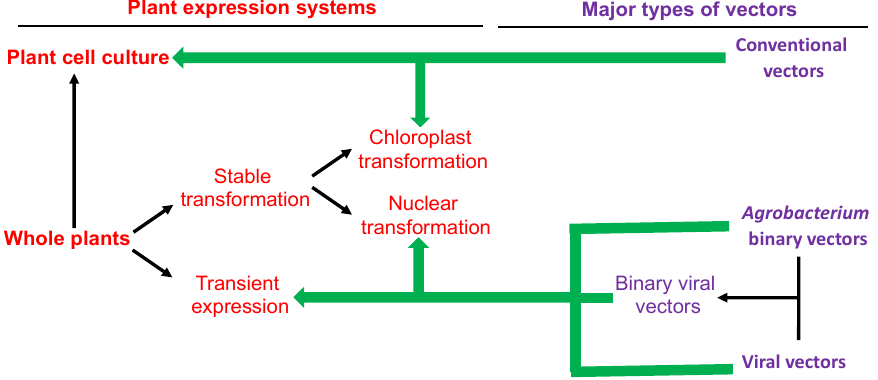
Figure 1. Major plant expression systems and vectors commonly used for production of recombinant proteins.